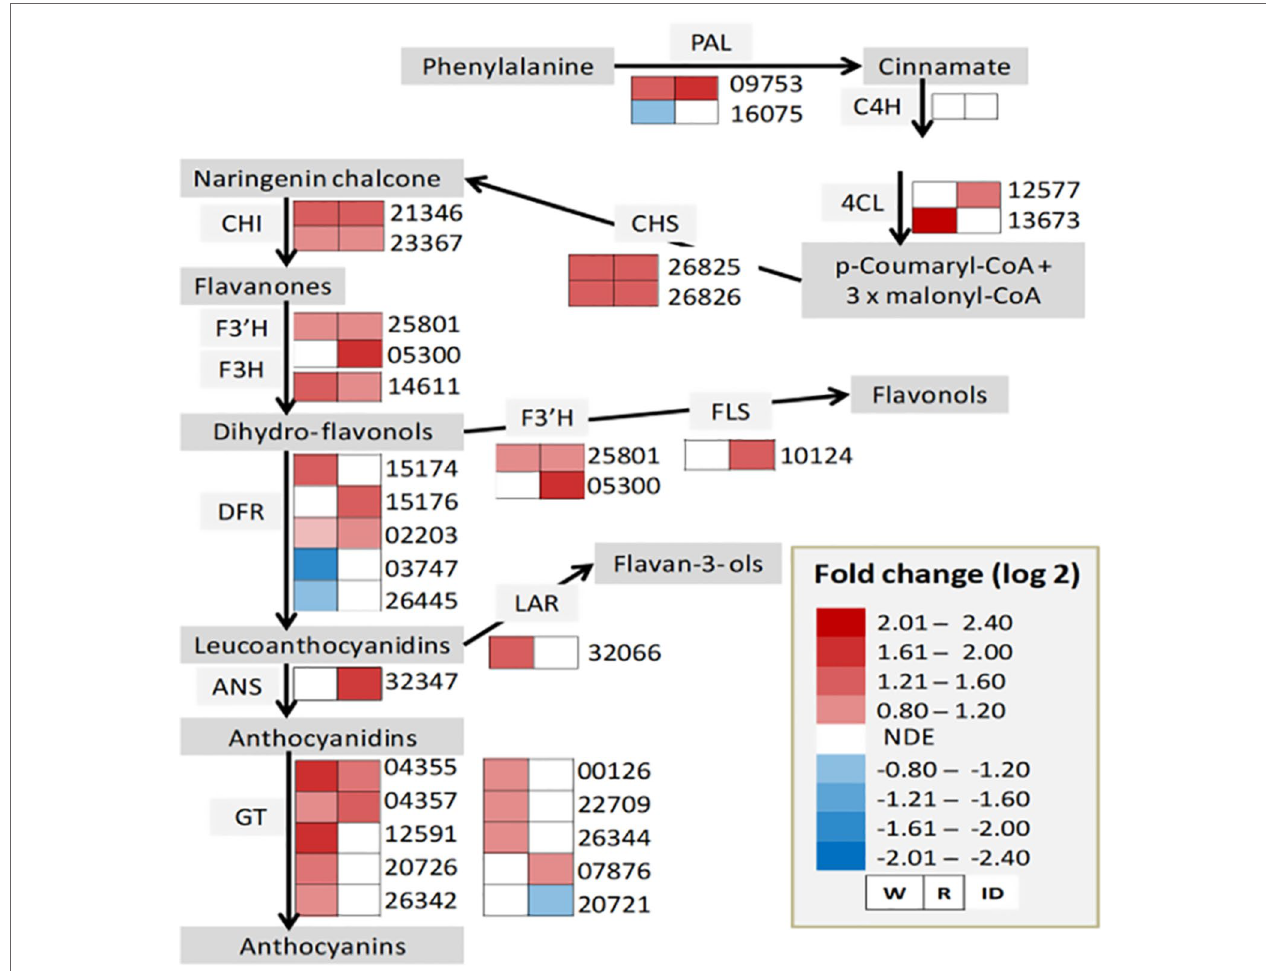
FIGURE 4 | Flavonoid biosynthesis pathway in Botrytis cinerea inoculated Fragaria vesca fruits at 24 h postinoculation. Heatmaps of gene expression (from RNA- Seq result) in inoculated white (W) and red (R) fruits. ANS, anthocyanidin synthase; C4H, cinnamic acid 4-hydroxylase; CHI, chalcone isomerase; CHS, chalcone synthase; DFR, dihydroflavanol 4-reductase; F3’H, flavonoid 3’-monooxygenase; F3H, flavanone 3-hydroxylase; FLS, flavonol synthase GT, glycosyltransferase; LAR, leucoanthocyanidin reductase; PAL, phenylalanine ammonia-lyase; 4CL, 4-coumarate-coenzyme A ligase. NDE, not differentially expressed. Genes such as 02203, 05300, and 10124 are not in the DE genes list, but included for the completeness of the biosynthesis pathway. The expression profile for 02203 in W—log2 FC: 0.63, P value: 0.034; for 05300 in R—log2 FC: 2.0, P –value: 0.069; and for 10124 in R—log2 FC: 1.6, P –value: